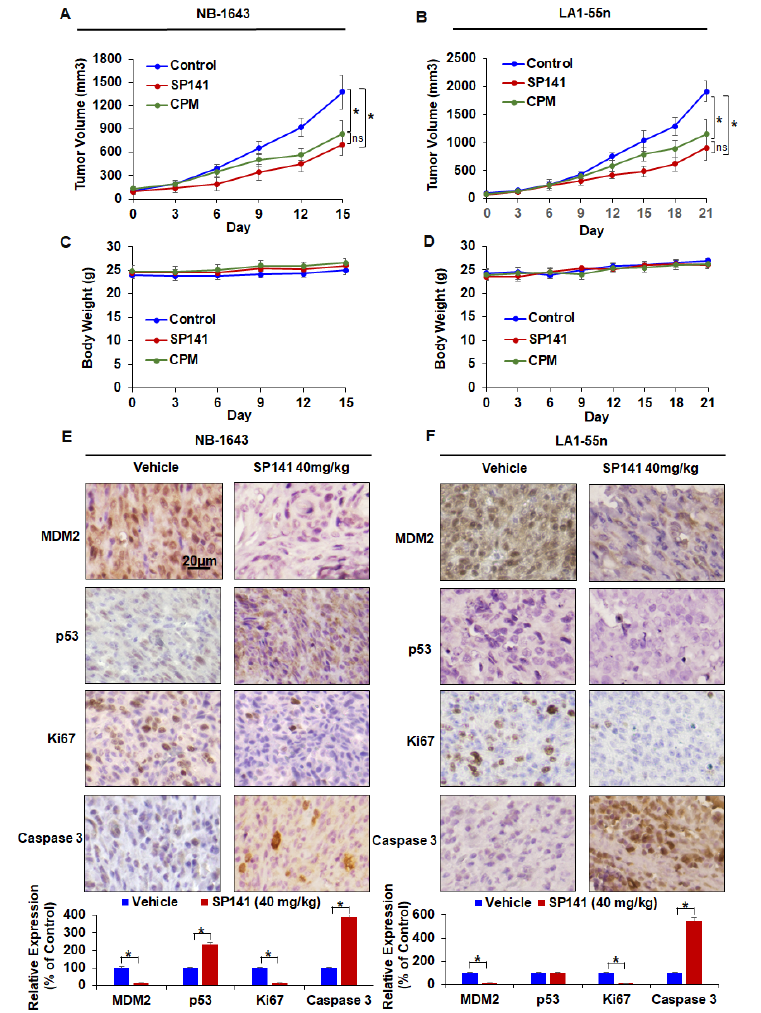
Figure 4. SP141 inhibits neuroblastoma xenograft tumor growth in vivo. Nude mice bearing NB-1643 and LA1-55n xenograft tumors were treated with SP141, which was administered by i.p. injection at 40 mg/kg/day, 5 d/week for 15 and 21 days, respectively. ( A,B ) Tumor growth curves of NB-1643 and LA1-55n xenograft tumors are shown. Each point on the line represents the mean tumor volume, and the bars represent the SEM. ( C,D ) Animals were monitored for changes in body weight as a surrogate marker for toxicity in both xenograft models. Each point on the line represents the mean body weight and the bars represent the SEM. ( E,F ) At the end of the experiments, NB-1643 and LA1-55n xenograft tumors were removed and further analyzed for their protein expression by immunohistochemistry (scale bar, 20 µm). Graphs (lower panel) show the quantification of the positive cells. The data were analyzed by an ANOVA with post-hoc test and are shown as the means ± SEM. ( # p < 0.05, * p < 0.01, and “ns” denotes “not significant).